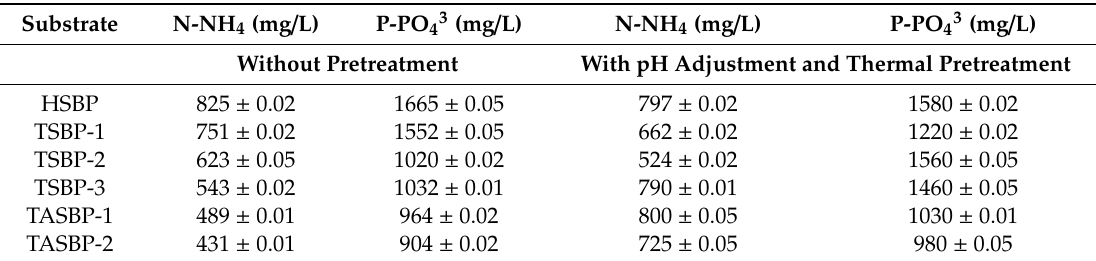
Table 4. Concentrations of ammonia and phosphates in the digestates.